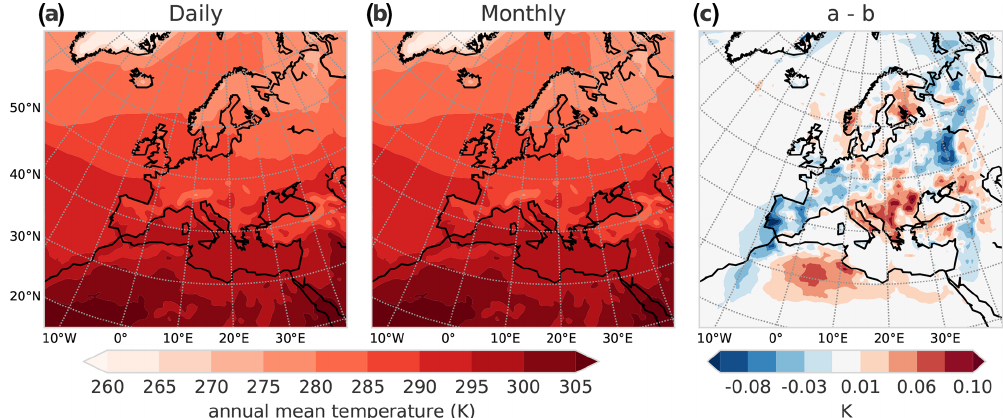
Figure 12. Annual mean temperature distribution for 2070–2099 in a PGW simulation depending on the selected temporal resolution of the input data. (a) PGW simulation where smoothed daily changes have been used to modify the lateral boundaries (blue line in Fig. 3). (b) PGW simulation where a linear interpolation between monthly mean changes was applied (orange line in Fig. 3). (c) Difference between panels (a) and (b)